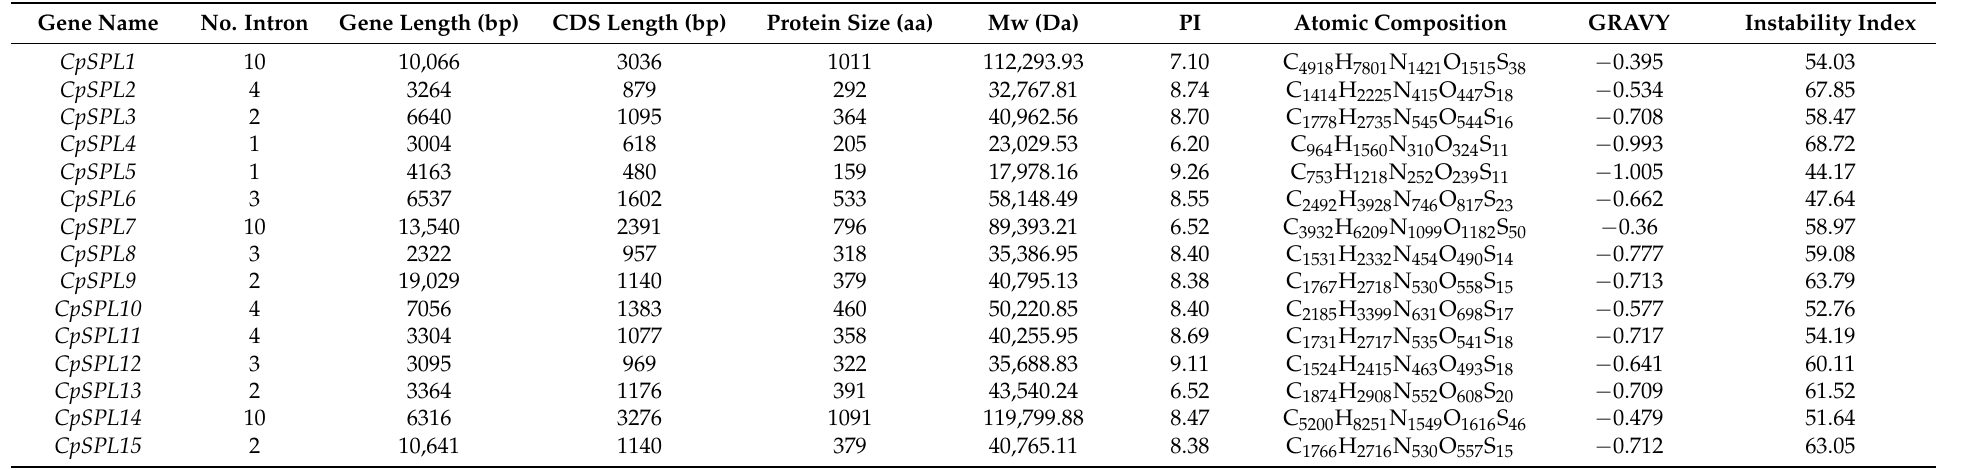
Table 1. The information of 15 SPL genes in Codonopsis pilosula